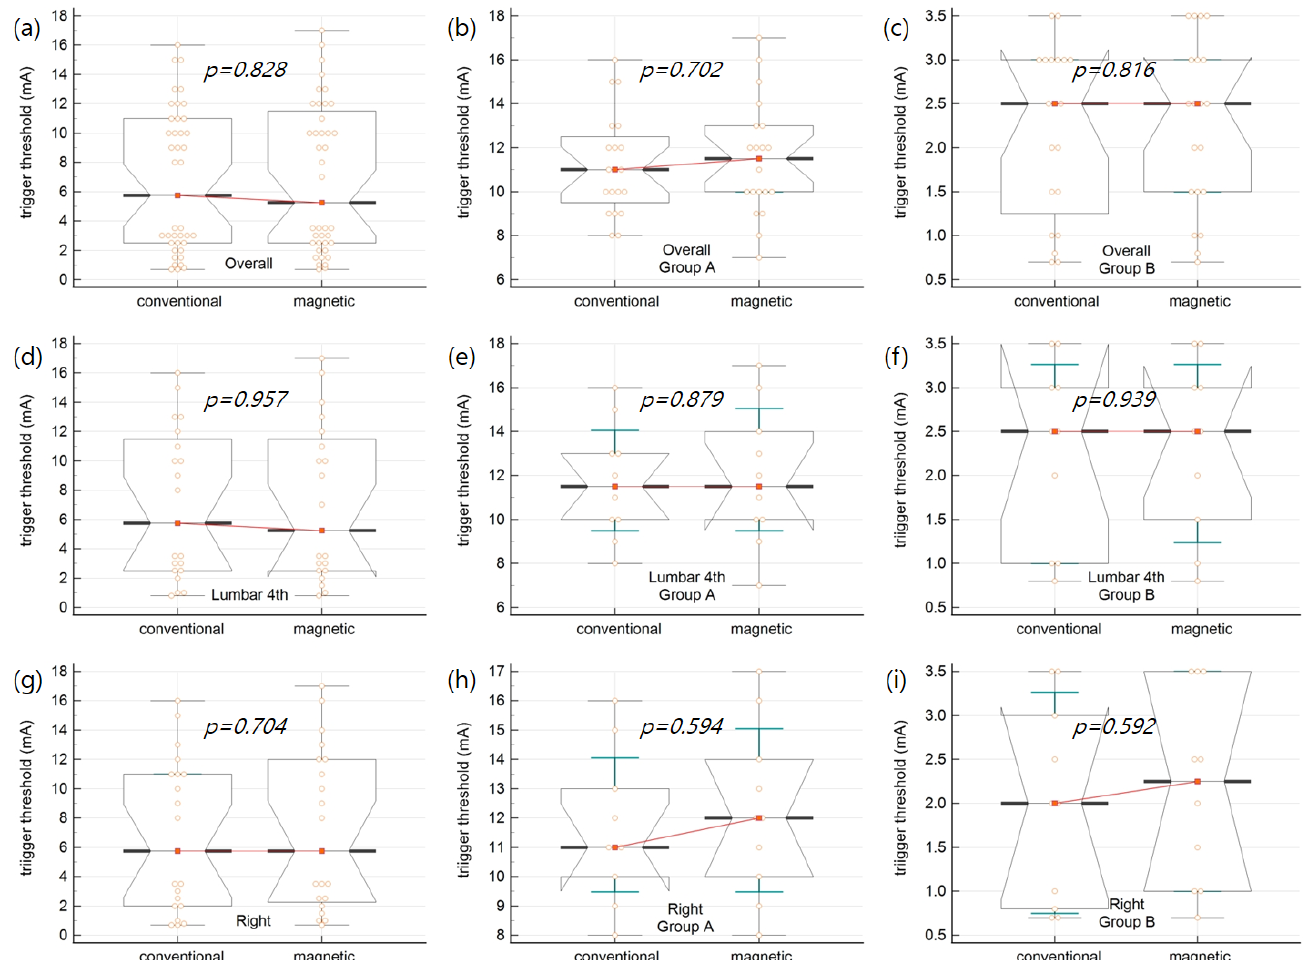
Figure 6. Comparison of triggered threshold according to the use of conventional stimulator and novel magnetic stimulator. Group A (intact pedicle wall), Group B (broken pedicle wall). ( a – c ) Overall, ( a ) total ( n = 40), ( b ) Group A ( n = 20), ( c ) Group B ( n = 20), ( d – f ) 4th lumbar vertebrae, ( d ) total ( n = 20), ( e ) Group A ( n = 10), ( f ) Group B ( n = 10), ( g – i ) Right side, ( g ) total ( n = 20), ( h ) Group A ( n = 10), ( i ) Group B ( n = 10).